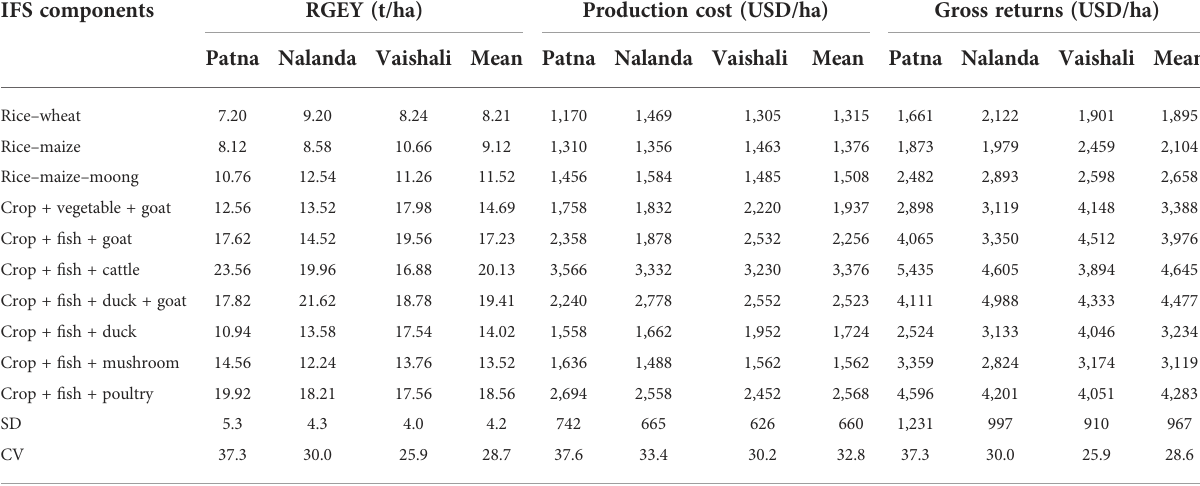
TABLE 4 Average productivity (RGEY) t/ha and economics of different combinations at three places in developed IFS models (mean data of 6 years, 2016 – 2021). IFS